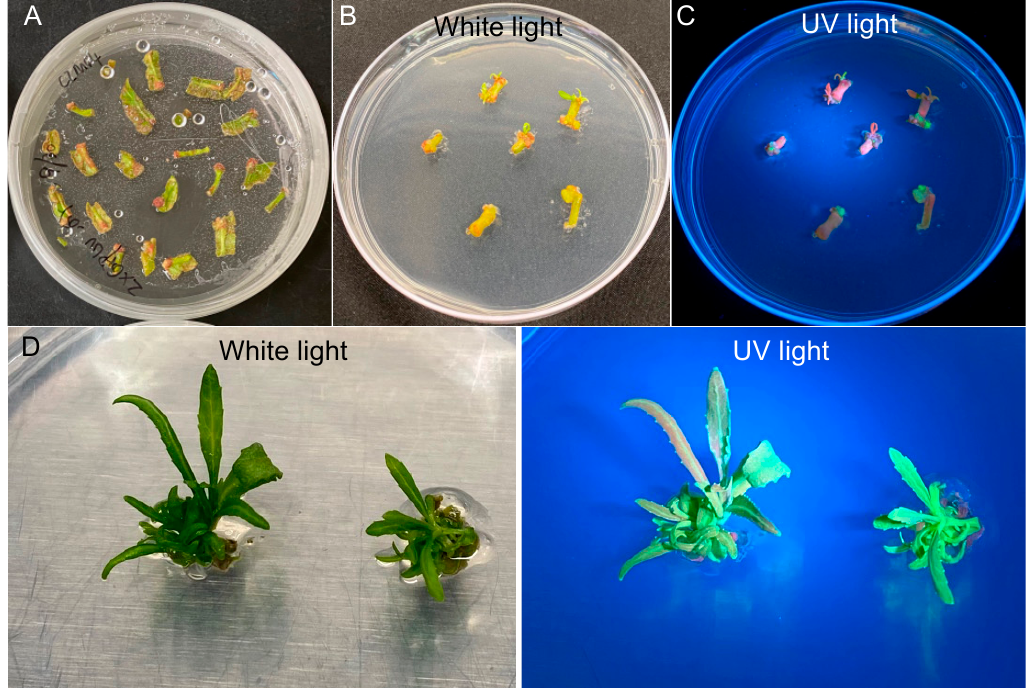
Figure 3. Quantification of transformation efficiency in different stages of plant transformation. ( A ) The explants survived on selection medium. ( B ) The explants with shoot induction. ( C ) The explants with at least one GFP callus. ( D ) The explants with at least one GFP shoot. Table 1. Quantification of transformation efficiency during plant regeneration.